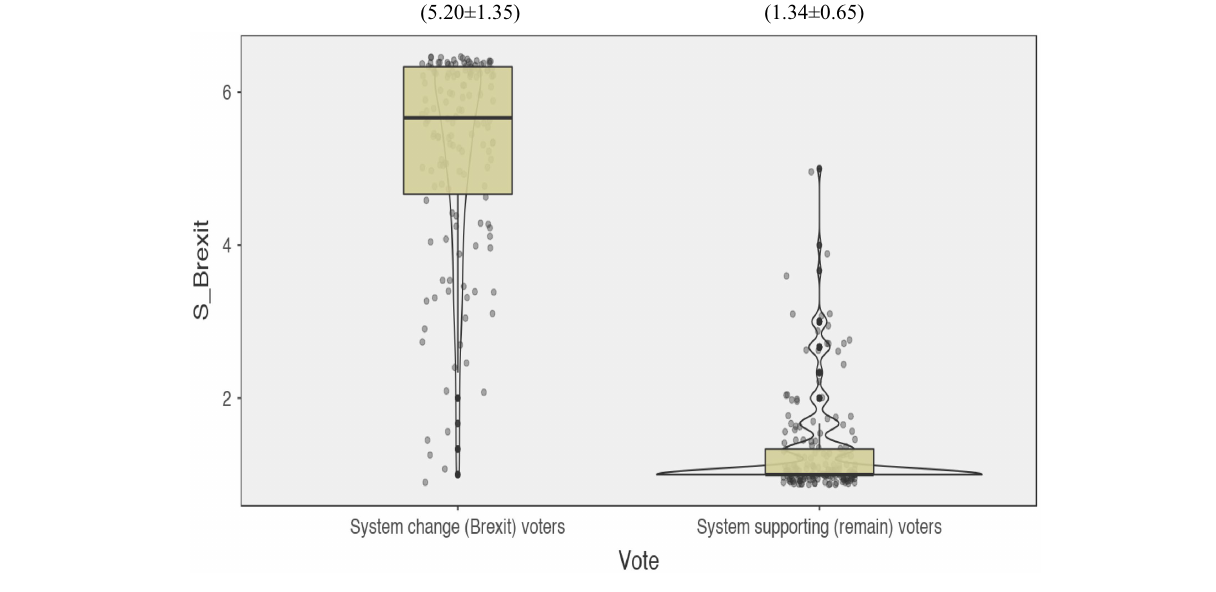
FIGURE 1 | Violin plots for the distribution of scores within the system supporting vs. system change voting groups for post-referendum support for the new Brexit era. Numbers above the plots = (Mean ± SD ). S_Brexit = support for